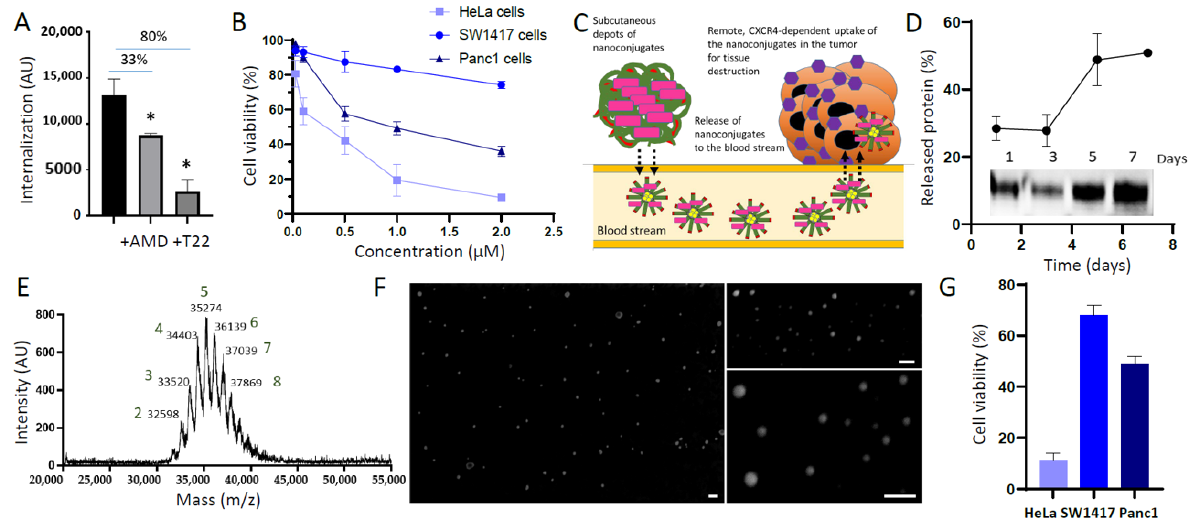
Figure 2. Release of CXCR4-targeted cytotoxic nanoconjugates from protein–drug depots. ( A ). Internalization of T22 ‐ GFP ‐ H6 ‐ ATTO488 MPs into HeLa cells in absence or in presence of the CXCR4 antagonist AMD3100 (AMD) or soluble T22 ‐ GFP ‐ H6 (T22). AU are arbitrary fluorescence units. ( B ). Dose ‐ dependent viability of three different CXCR4 + cell lines upon exposed to T22 ‐ GFP ‐ H6 ‐ MMAE MPs for 48 h (HeLa and Panc ‐ 1) and for 72 h (SW1417). ( C ). A model for the expected release of nanoconjugates from MP depots and remote targeting to and destruction of CXCR4 ‐ overexpressing